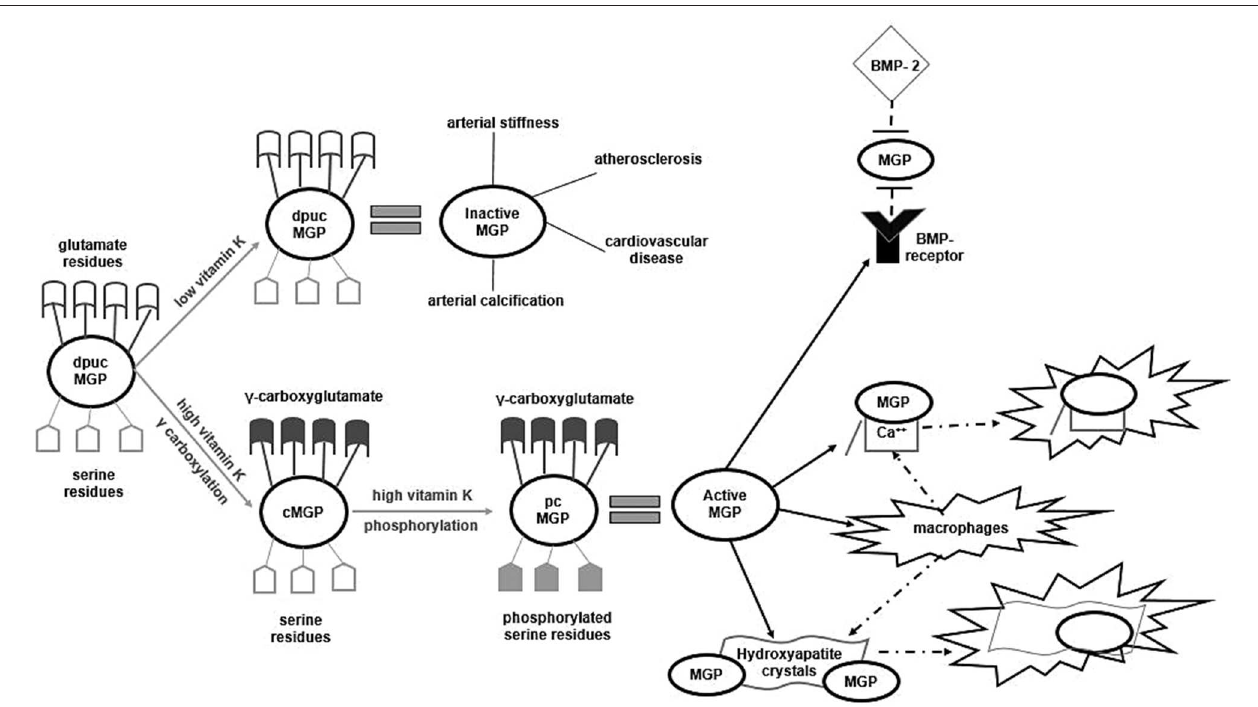
FIGURE 1 | Activation/inactivation processes of Matrix Gla Protein. Dp-ucMGP is the fully inactive form of MGP. If vitamin K is deficient, MGP remains in its inactive form and favors arterial calcification or stiffness, atherosclerosis and subsequent cardiovascular disease. In states of high vitamin K, dp-ucMGP undergoes γ -carboxylation of its glutamate residues and transforms to the cMGP form. In turn, using vitamin K as co-factor, cMGP undergoes phosphorylation of its serine residues and become the fully activated pcMGP. Only in this form, MGP abrogates the connection of BMP-2 to its receptor, tightly binds to free calcium and hydroxyapatite crystals to from inactive complexes and activates autophagic clearance of these complexes by attracting phagocytes and macrophages. MGP, Matrix Gla Protein; dp-ucMGP, dephoshorylated uncarboxylated MGP; cMGP, carboxylated MGP; pcMGP, phosphorylated carboxylated MGP; Ca ++ , calcium anions; BMP, Bone Morphogenetic